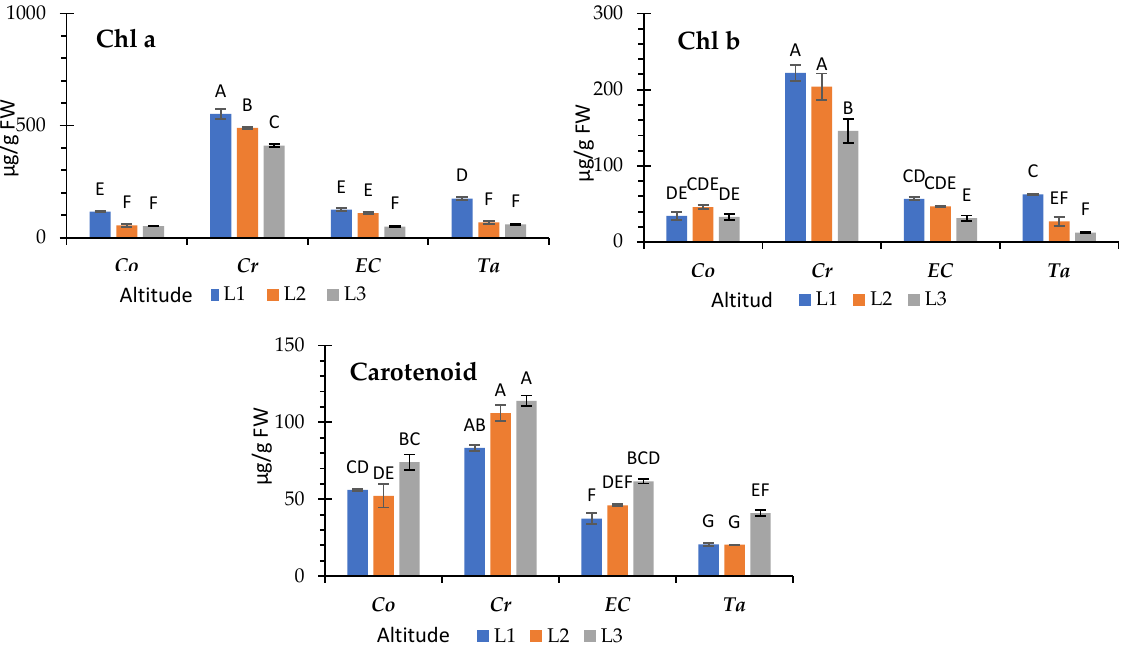
Figure 4. Photosynthetic pigment content (chlorophyll a, chlorophyll b, and carotenoids) in the leaves of four plant species from different altitudes. Each value is the mean of three replicates ± SE. At p ≤ 0.05, bars with different letters are significantly different. Abbreviations: L1 = altitude 1; L2 = altitude 2; L3 = altitude 3; Co . = Cotineaster orbicularis ; Cr. = Crataegus sinaica; Ec. = Echinops spinossissmus; Ta. = Tanacetum sinaicum.